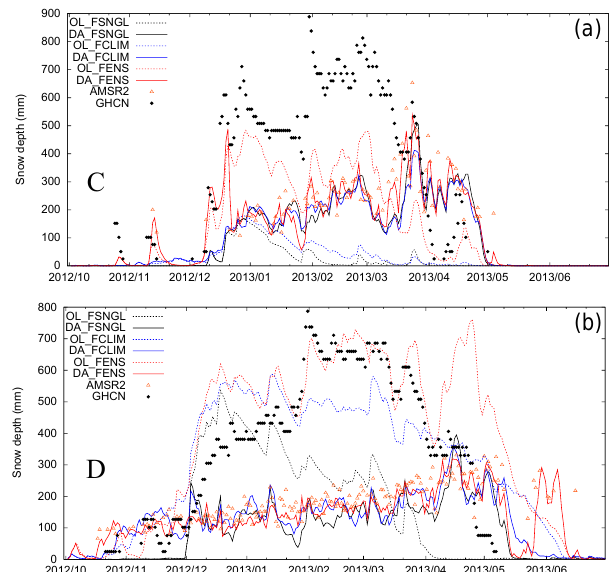
Figure 8. Time series of snow depth fields at location C (a) and D (b) from model open loop (OL_FSNGL, OL_FCLIM and OL_FENS), data assimilation (DA_FSNGL, DA_FCLIM and DA_FENS), AMSR2 and in situ